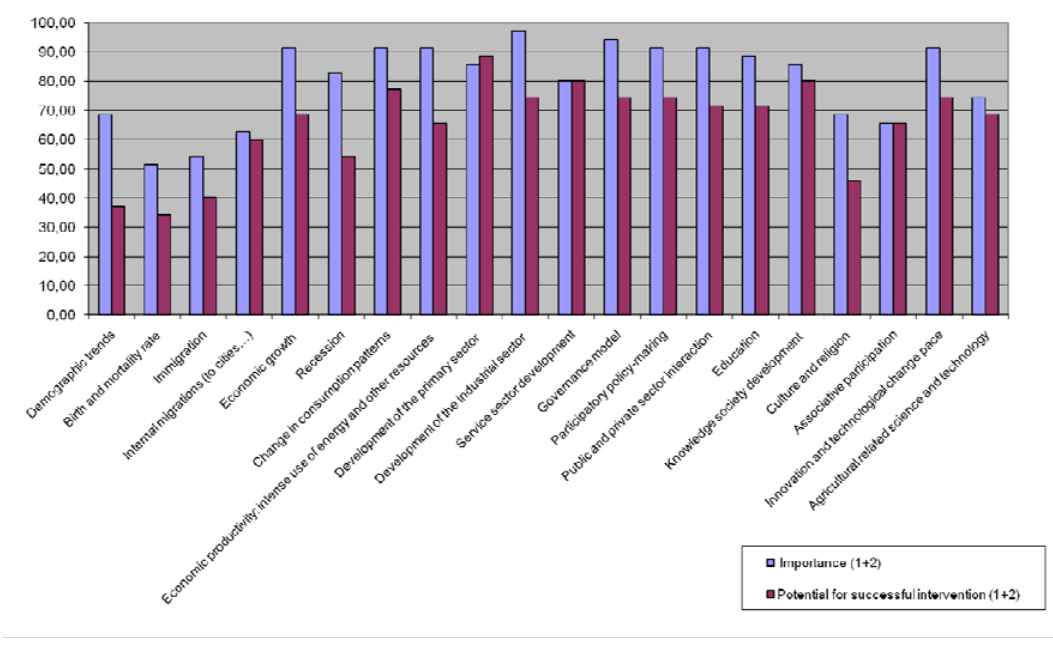
Fig. A2.1: Importance and potential for successful intervention for the different indirect drivers analyzed in the questionnaire completed by participants before the workshops. The importance is measured as the percentage of respondent that value each indirect driver of high importance (=1) or important (=2); whereas potential for successful intervention is measured as the percentage of respondent that reported a high (=1) or medium (=2) potential for successful intervention from Biscay for each of the studied indirect